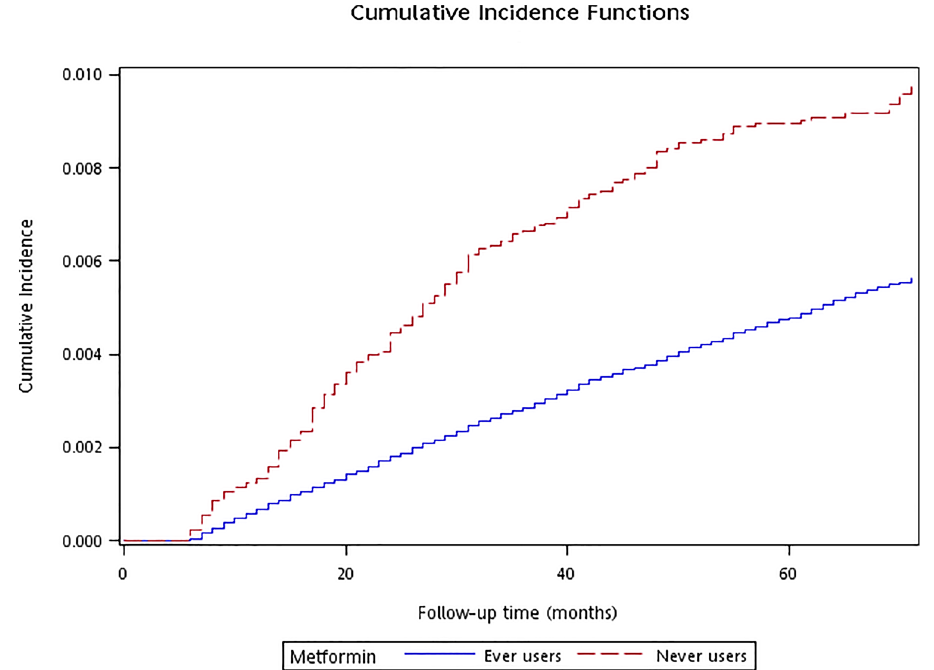
Figure 2. Cumulative incidence functions of acute appendicitis in never users and ever users of metformin (Gray’s test P <